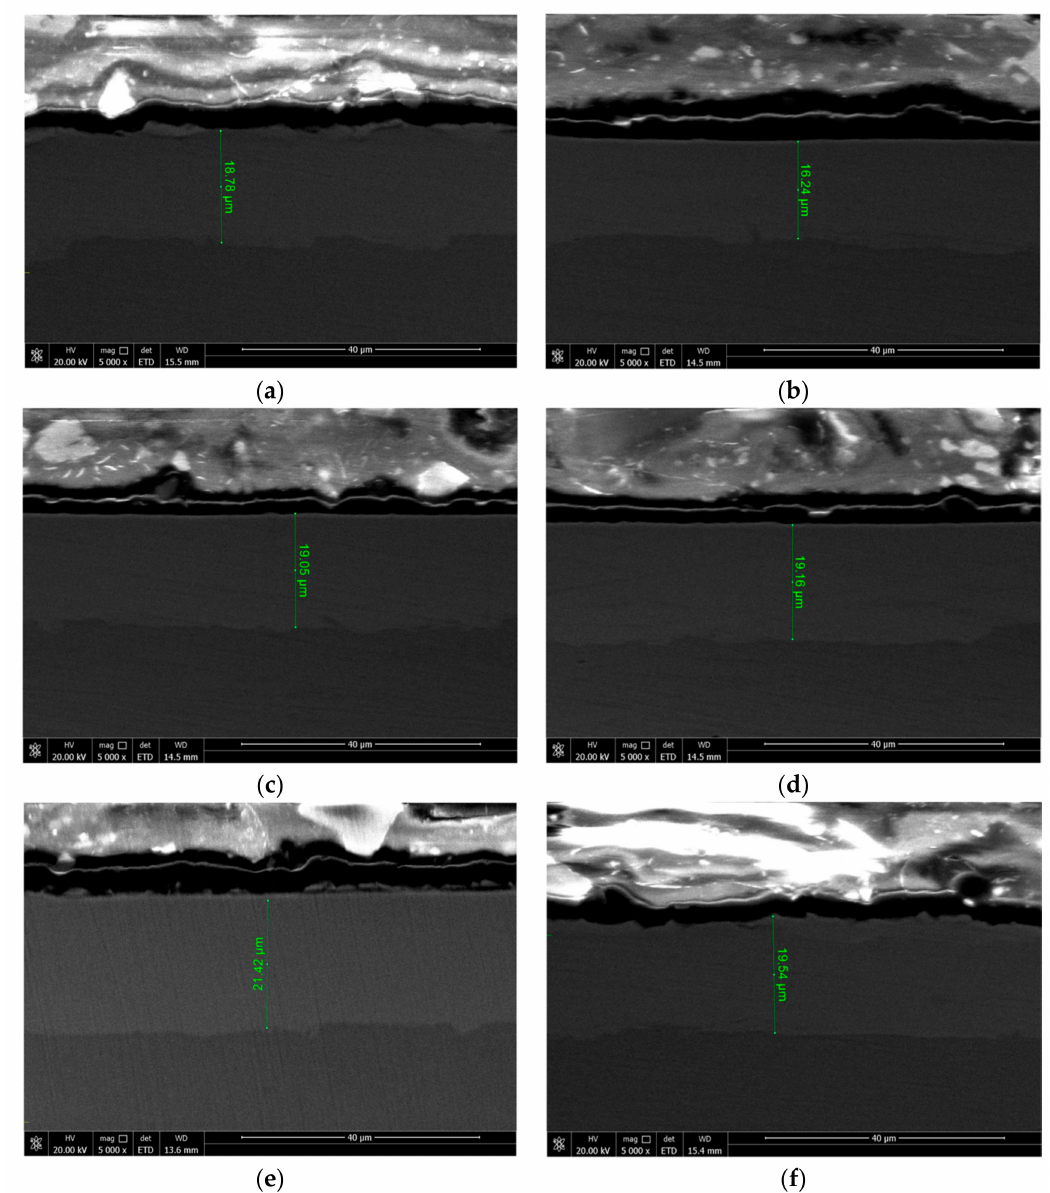
Figure 5. Section micro-morphology of the coating. ( a ) 30 A · dm − 2 ( b ) 20 A · dm − 2 ( c ) 30 A · dm − 2 ( d ) 40 A · dm − 2 ( e ) 50 A · dm − 2 ( f ) 60 A · dm − 2